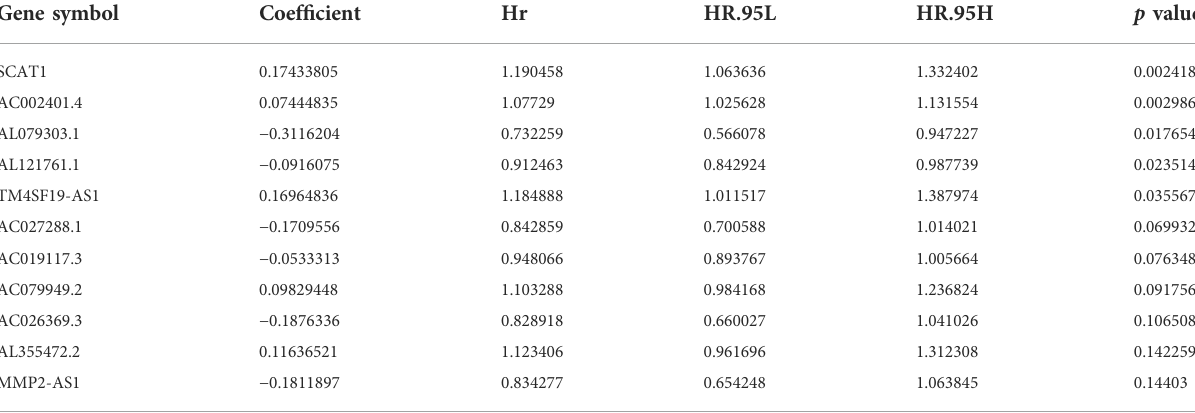
TABLE 2 Multi-variate Cox regression analyses of the 11 of 495 genome instability-related lncRNAs associated with overall survival in NSCLC. Gene